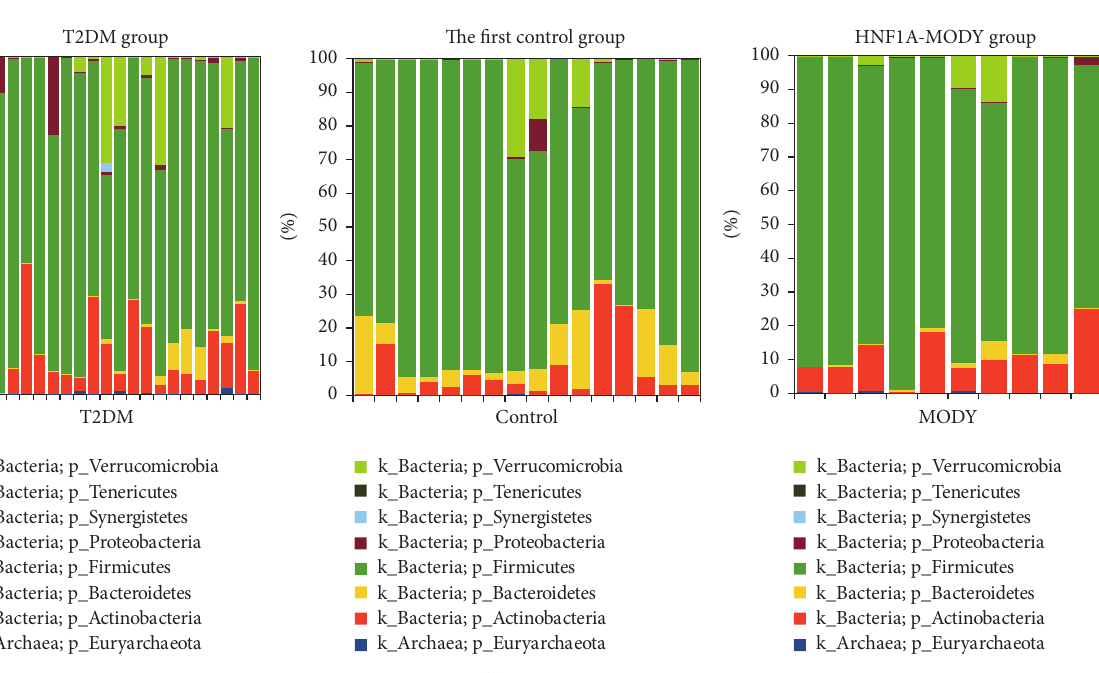
Figure 2: Comparison of frequencies of OTUs at the phylum level: (a) between groups (the first control group, HNF1A-MODY group, and T2DM group) and (b) between